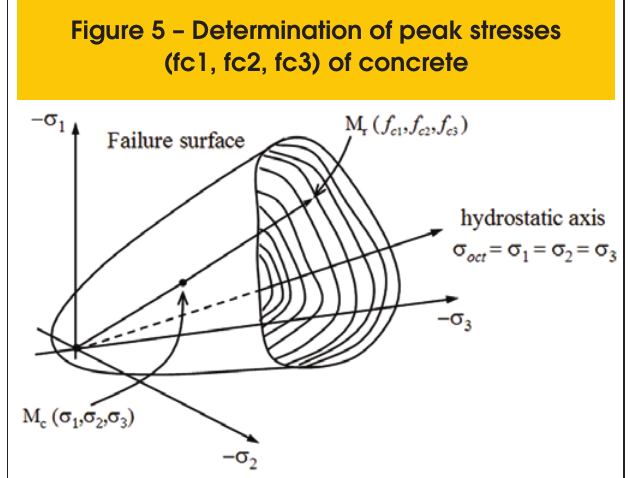
Figure 5 – Determination of peak stresses (fc1, fc2, fc3) of